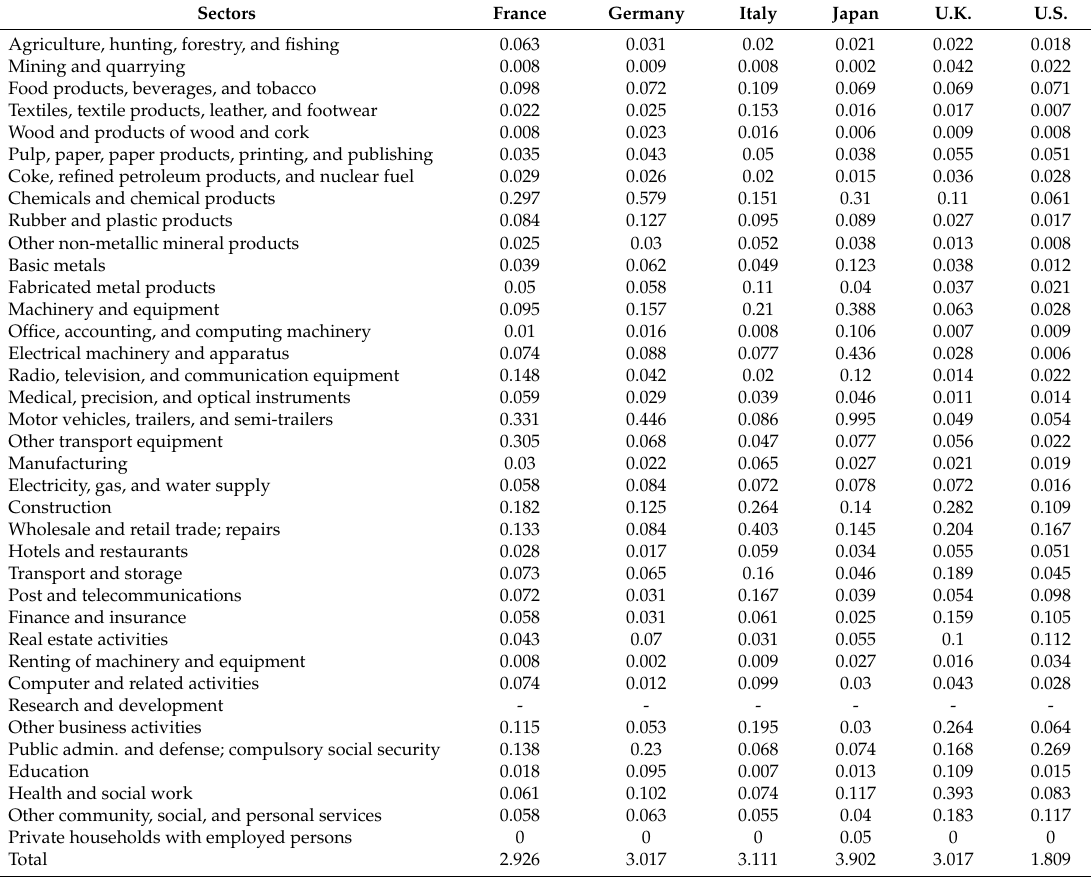
Table 4. Supply Shortage Effects of R&D Sector in Major OECD Countries.